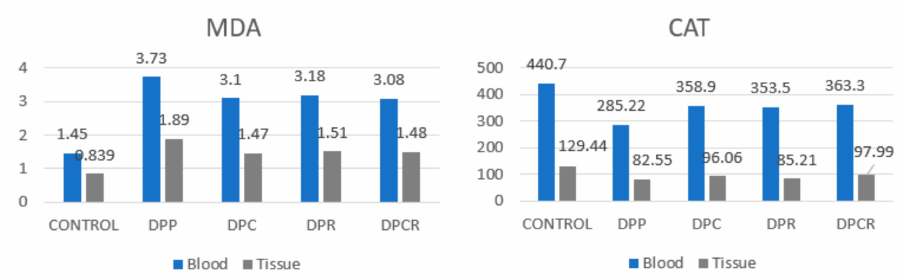
Figure 4. MDA and CAT markers in soft tissue and blood.